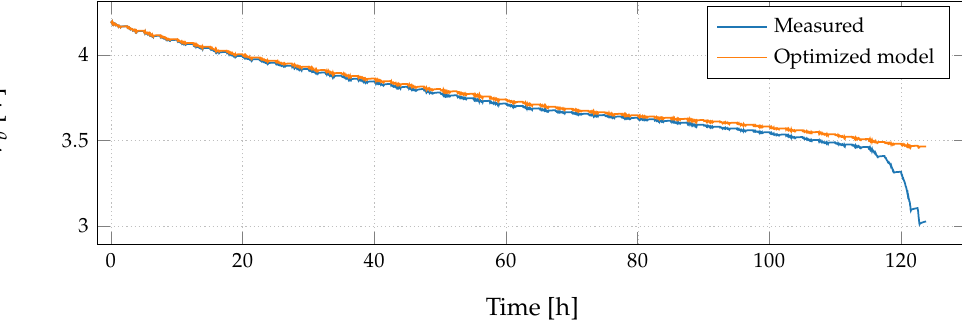
Figure 17. Performance of the model with a static ζ a on a single example of the random load. Moreover, green line shows a secondary model with a ζ a optimized for this specific experiment.